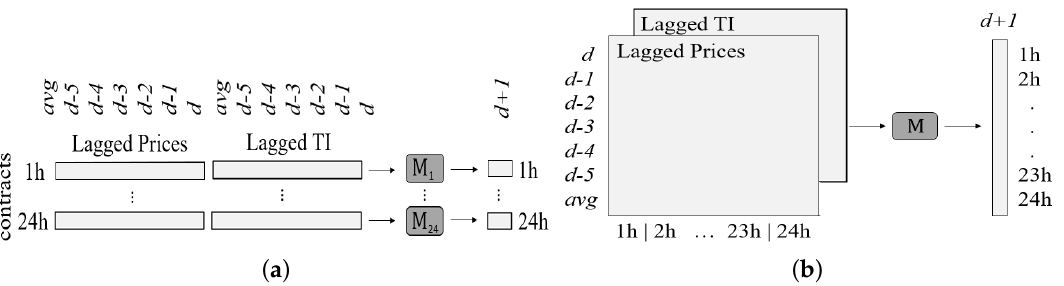
Figure 2. Diagrams displaying TI model inputs—lagged prices concatenated with a lagged TI—and outputs. Per Section 2.3.2, d to d − 5 represent the 6-day look-back period, while avg stands for the averaged 8-week look-back. M is a black box representation of ML models. ( a ) Linear and ensemble models; ( b ) Deep